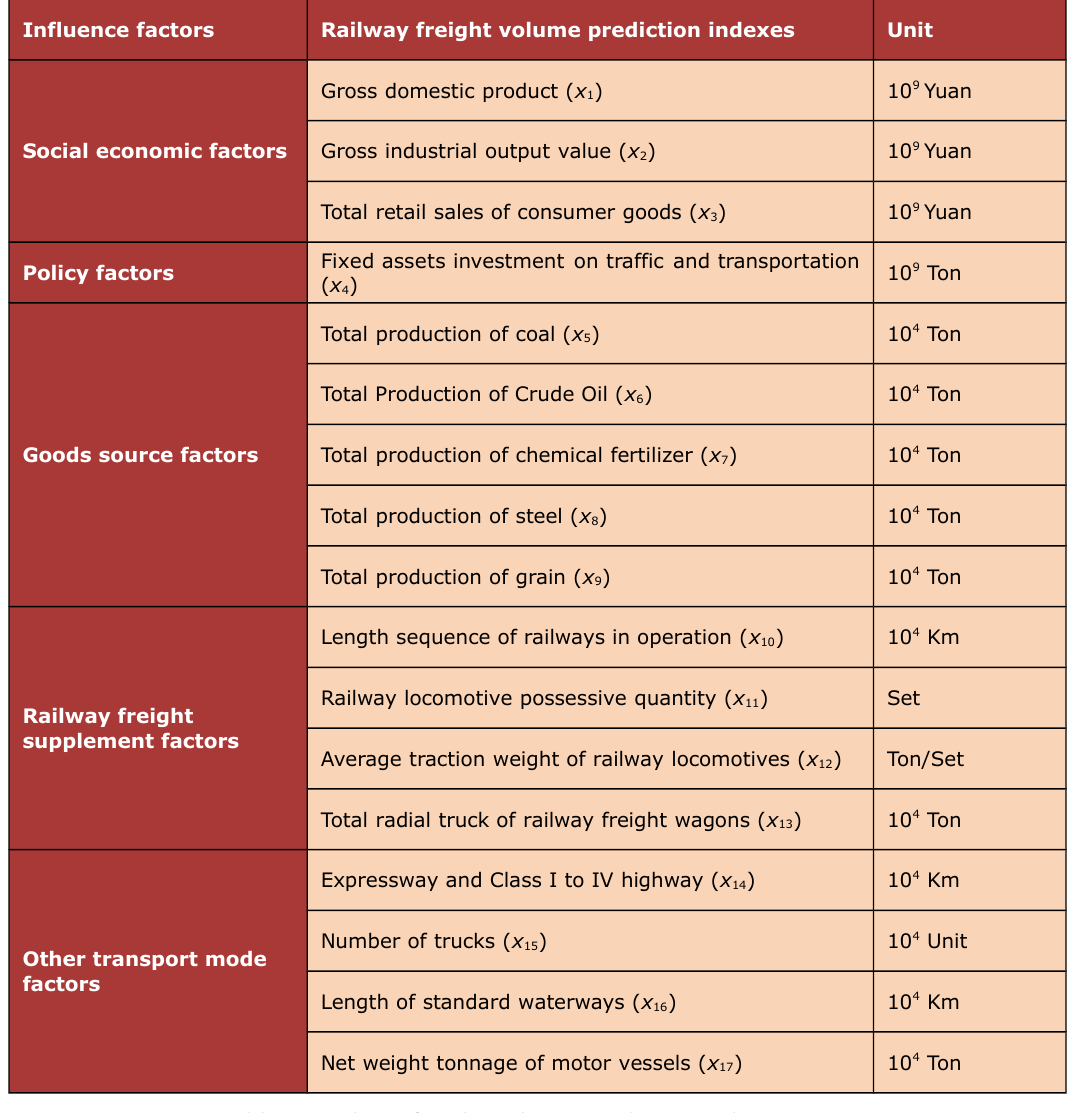
Table 1. Railway freight volume prediction index